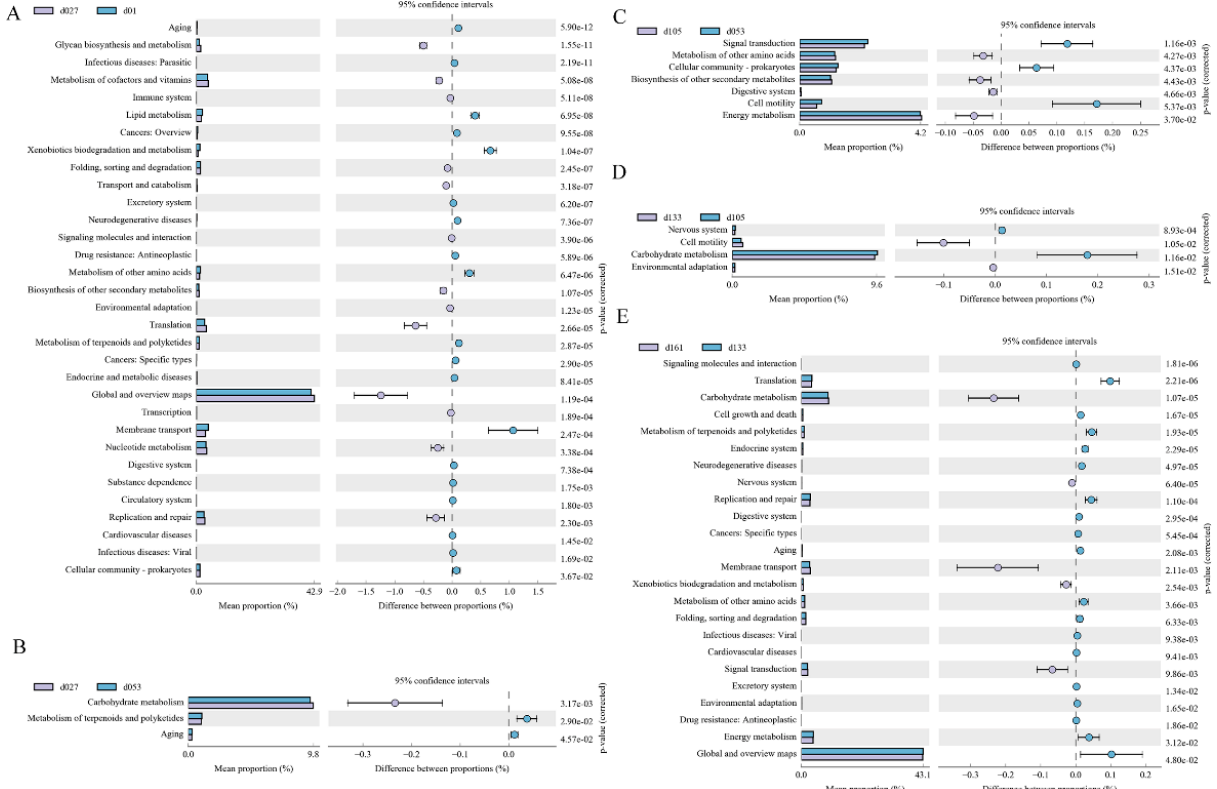
Figure 5. Enrichment of KEGG metabolic pathways of the cecal microbial community at different developmental stages of Wenchang chickens. ( A ) Functional pathways that changed significantly ( p < 0.05) between d01 and d027. ( B ) d027 vs. d053, ( C ) d053 vs. d105, ( D ) d105 vs. d133, ( E ) d133 vs. d161. d01, n = 12; d027, n = 11; d053, n = 12; d0105, n = 12; d133, n = 12; d161, n =